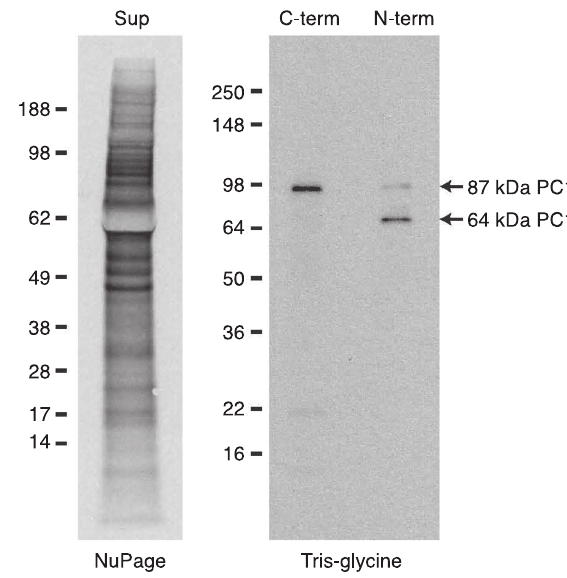
Figure 2. Immunoprecipitation of PC1 from AtT20 cells. To demonstrate the specificity of the immuno-purified PC1 C-terminal specific IgGs, an immunoprecipitation (IP) was performed on radiolabeled AtT20 cells. From a multitude of labeled proteins (Sup lane), one major band at 87 kDa was immunoprecipitated with these IgGs (C-term lane). As a control, immunoprecipitation with N-terminal specific PC1 IgGs yielded the two expected bands of 87 kDa and 64 kDa PC1 (N-term lane). A faint band at ~20 kDa was deemed non-specific as it was not immuno-reactive with the C-terminal specific IgGs in a Western blot of a subsequent IP of unlabeled AtT20 cell lysate (data not